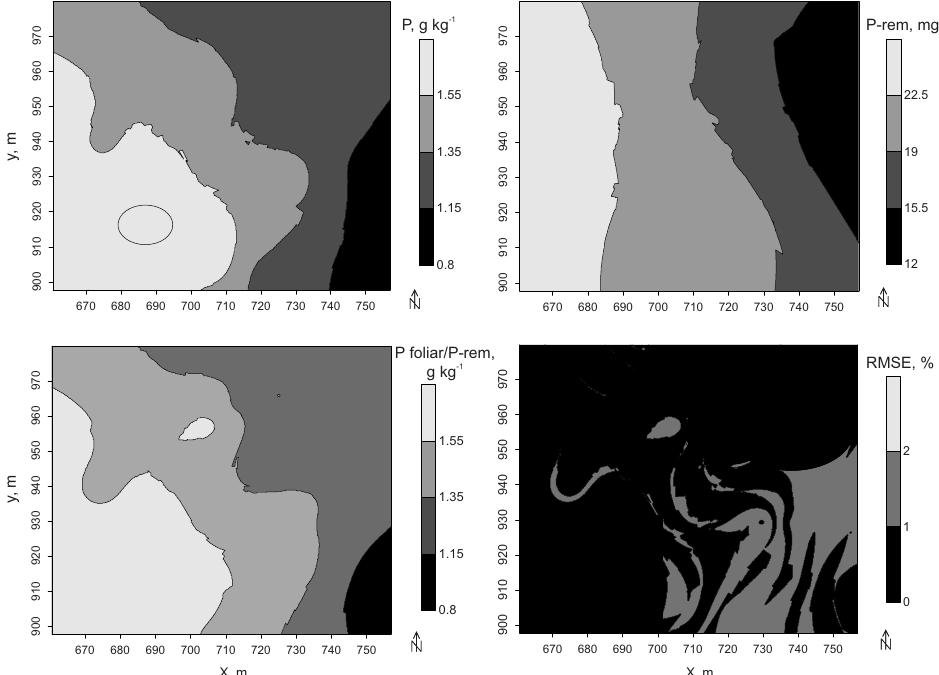
Figure 3. Spatial distribution maps obtained by ordinary kriging (foliar P and P-rem), cokriging (Pfoliar/P- rem) and root mean square error (RMSE) Coffea arabica L. cv.